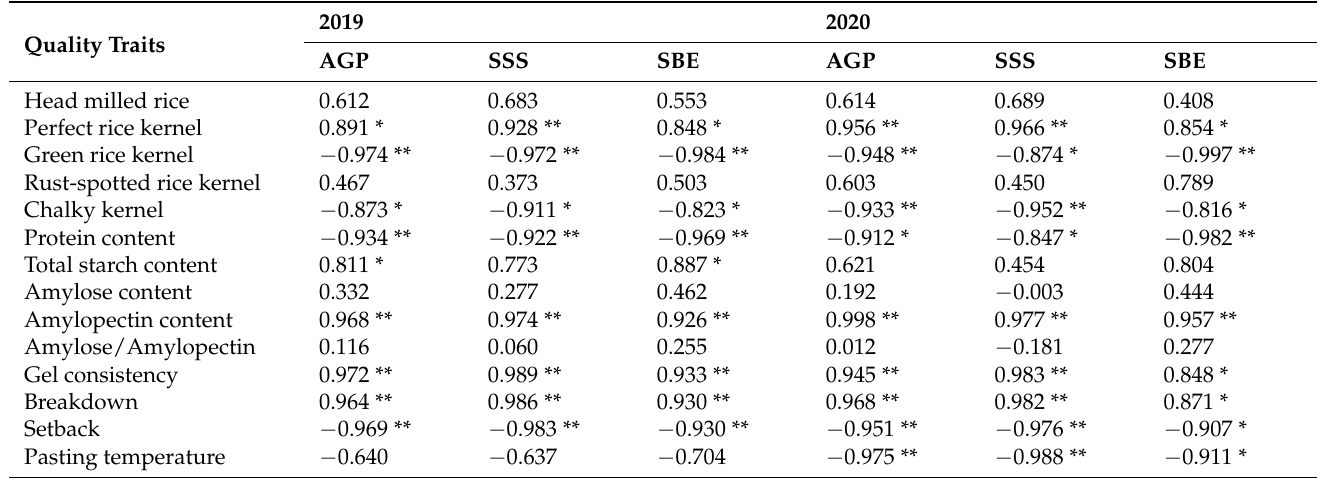
Table 5. Correlations between activities of key enzymes of sucrose-starch metabolism (AGP, SSS, and SBE) and rice